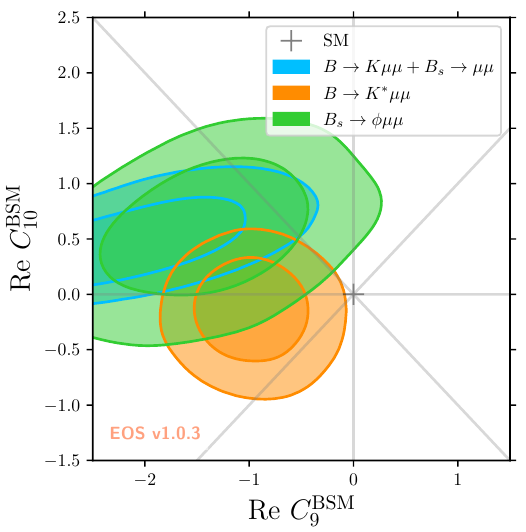
fit. All other Wilson , C BSM 9 10 + µ − , B → K ∗ µ + µ − , and B + µ − , s → µ s → φµ